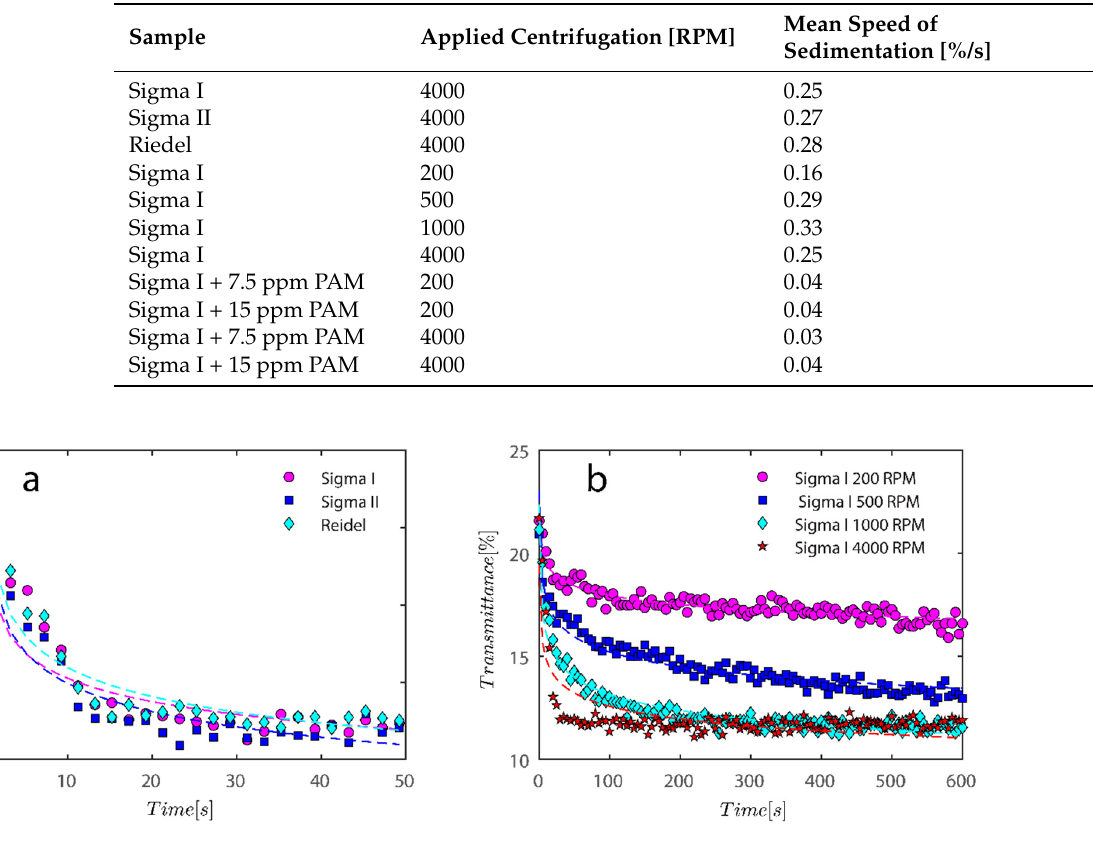
Table 2. Power law fits parameters associated with Figures 7–9.